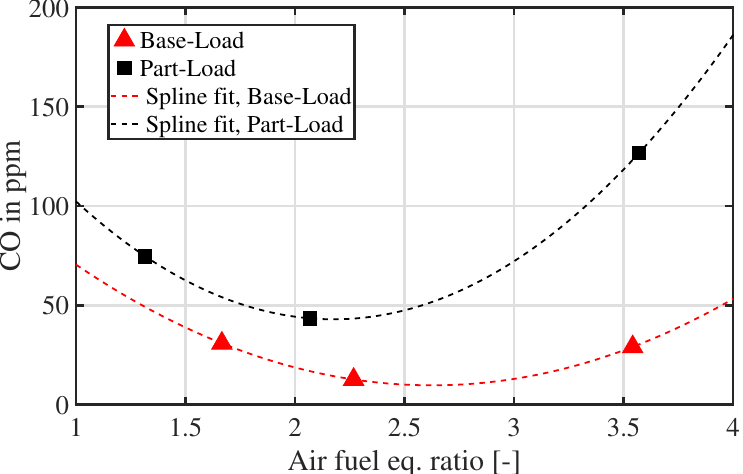
Figure 2. Investigated reference operation conditions normalized to 15% oxygen content [48] from exhaust gas emission measurements. Base-load fit: CO = 23 λ 2 − 121 λ + C 1 , with C 1 = 168.33. Part-load fit: CO = 43 λ 2 − 187 λ + C 2 , with C 2 =